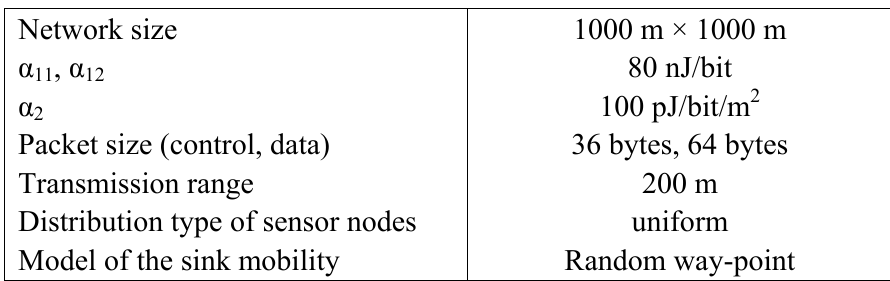
Table 1. Simulation